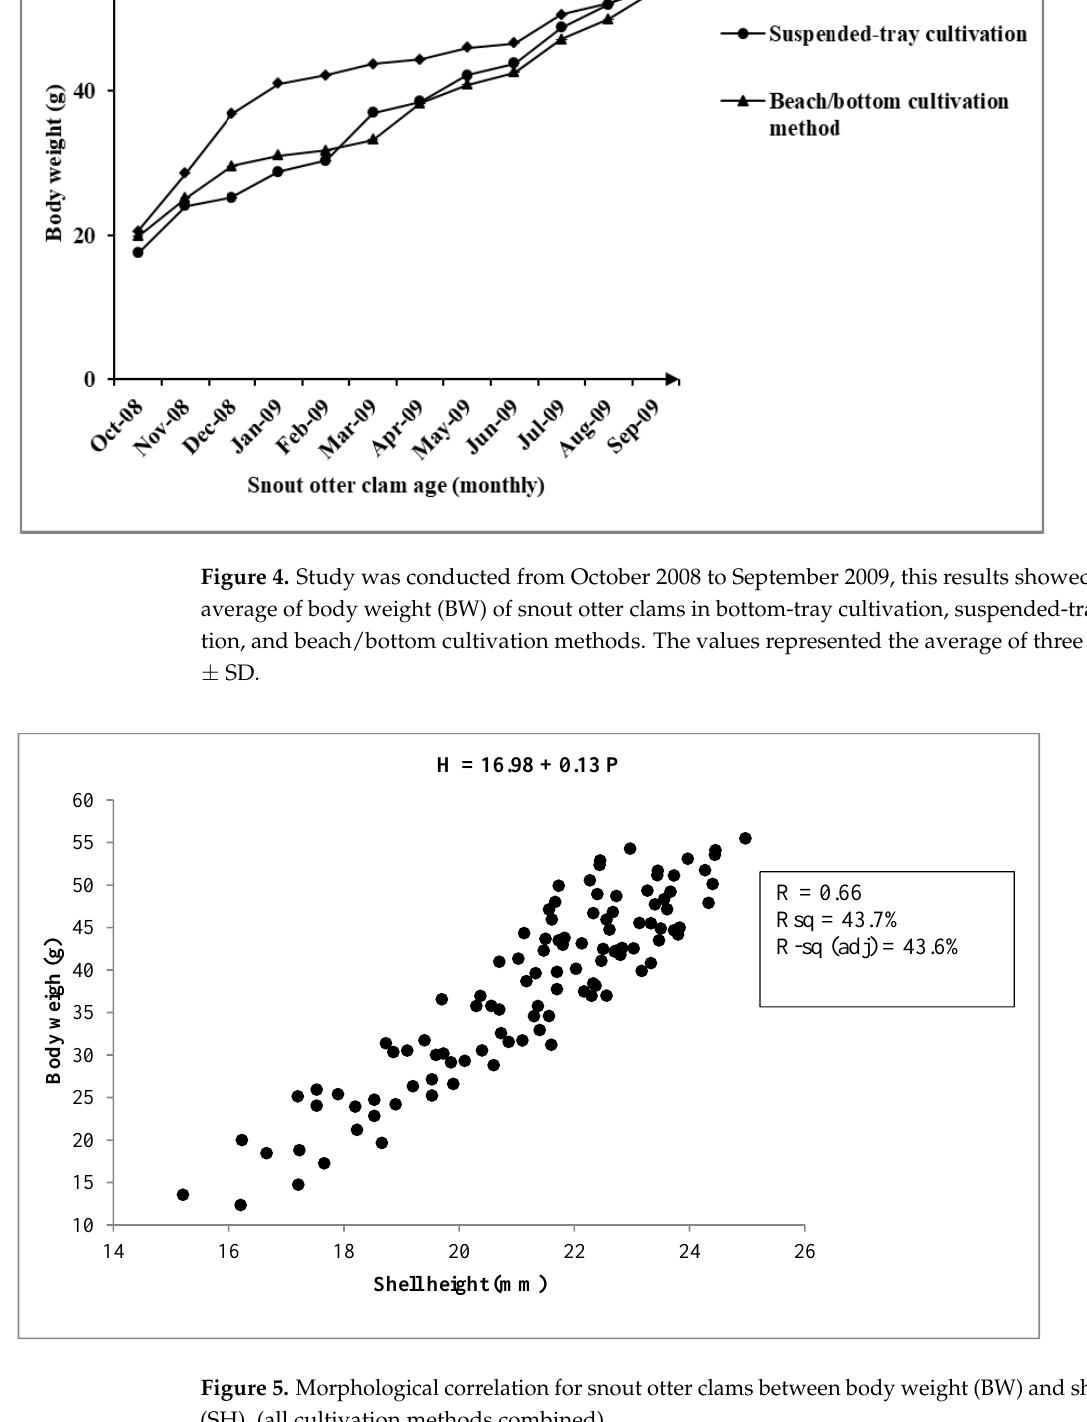
Table 1. Body weight, soft tissue weight, and fatness of snout otter clams in three different methods of growing.